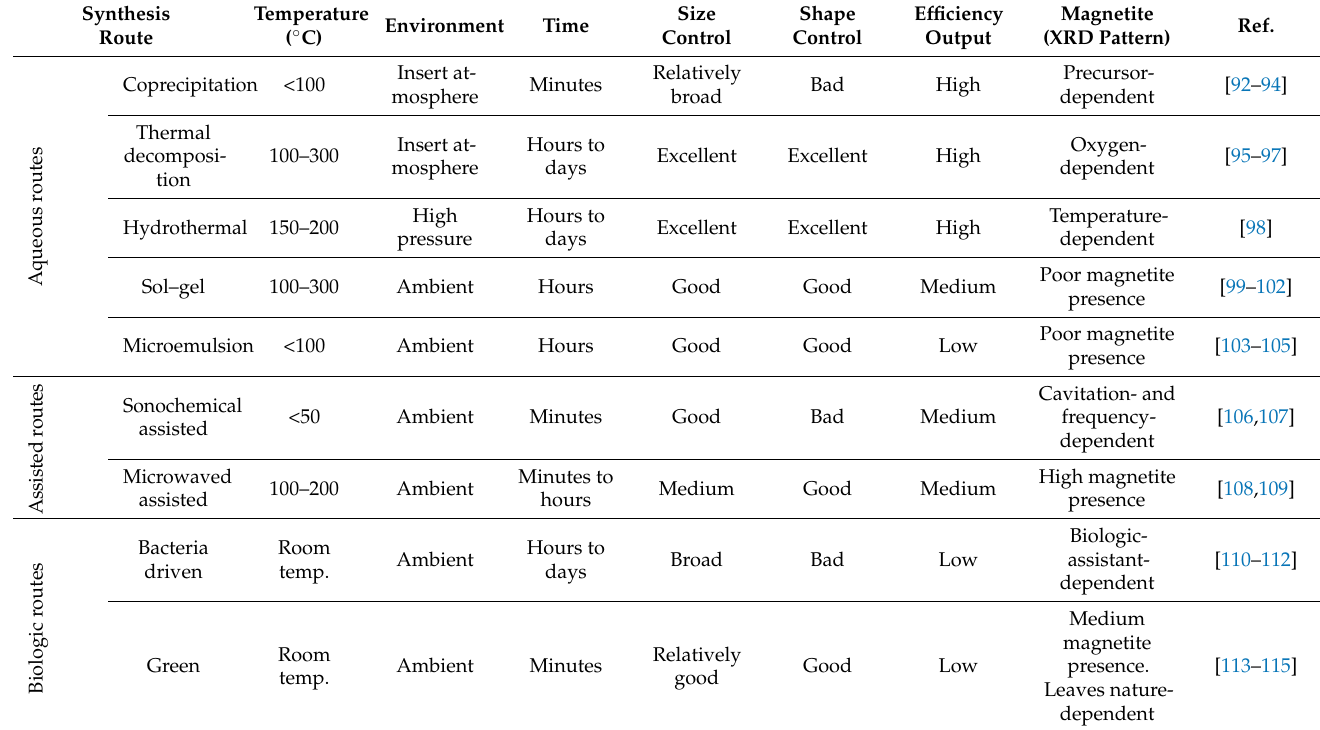
Table 1. Comparison between synthesis routes for the formation of MNPs